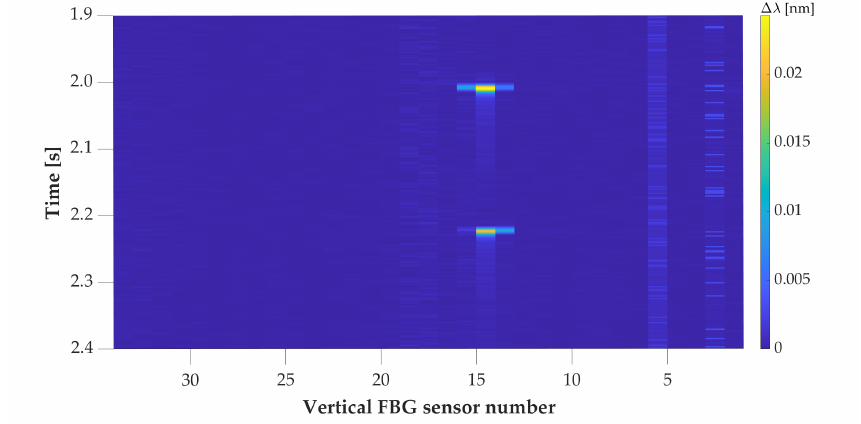
Figure 7. Record detail of the pressure map for the overpassing vehicle with left wheels. The colormap represents the values of the wavelength change of the reflected optical spectrum by FBG in